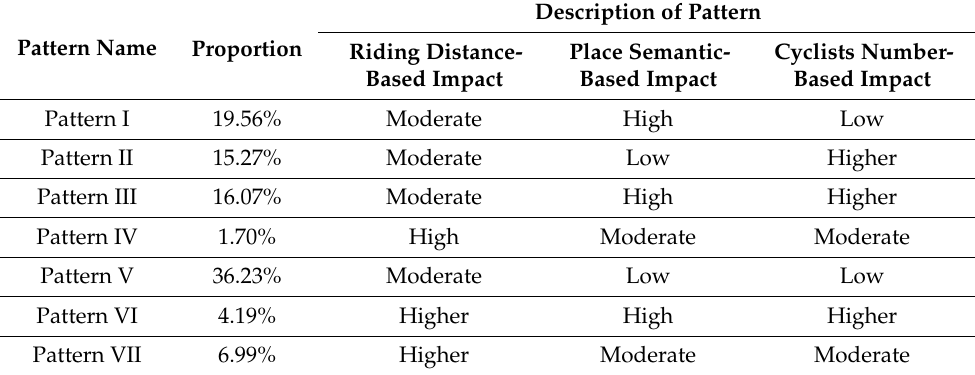
Table 3. Statistical and descriptions for the spatial patterns on